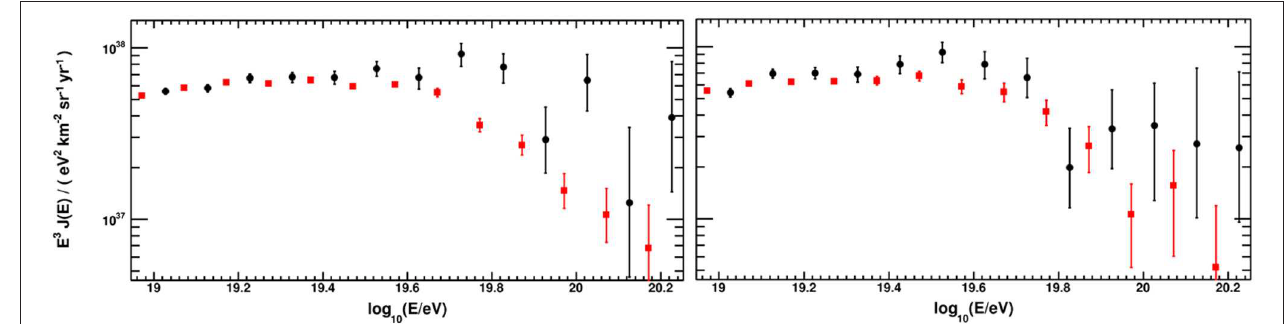
FIGURE 3 | Left: Comparison of the UHECR energy spectrum of Auger and TA after rescaling the energies of Auger by +5.2% (red squares) and that of TA by 5.2% (black circles). Right: Keeping the rescaling factors of the left figure, but restricting the declination to − observed. Reproduced with permission from The Pierre Auger and Telescope Array Collaborations